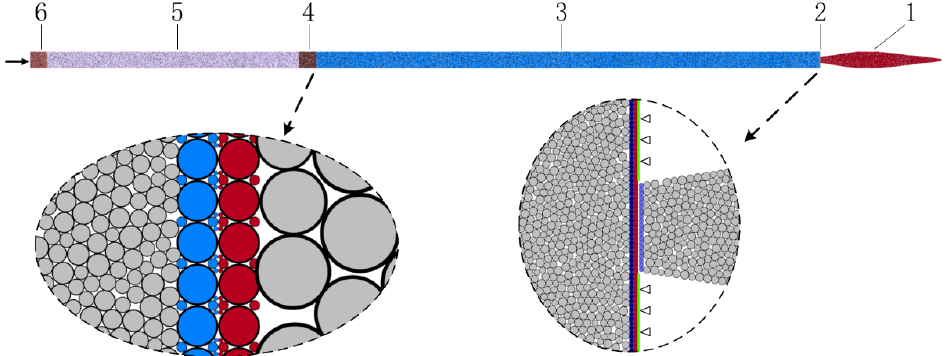
Figure 2. Numerical model of SHPB test system (1: Striker, 2: Fixed board, 3: Incident bar, 4: Specimen, 5: Transmitted bar, 6: Absorbing bar).